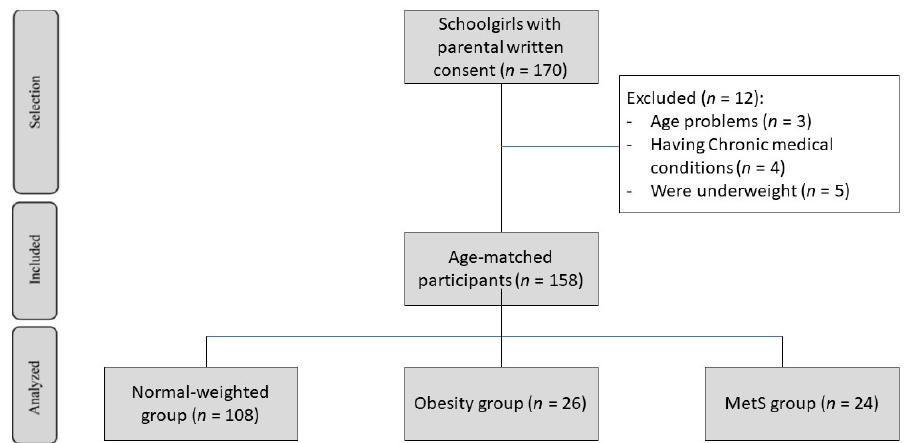
Figure 1. Flow chart of the study progress.